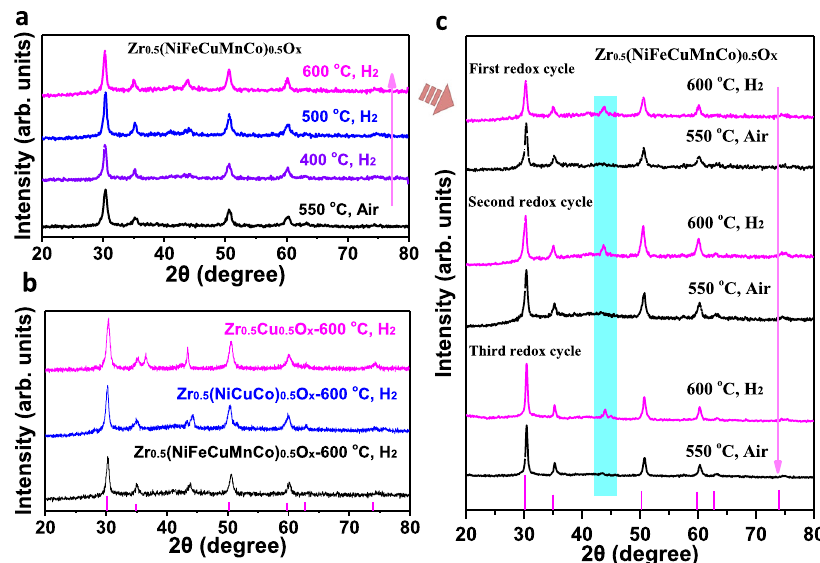
Fig. 5 The XRD patterns of doped ZrO x samples during redox processes. a The P-XRD patterns of Zr 0.5 (NiFeCuMnCo) 0.5 O x treated at 10% H 2 balance with N 2 at appoint temperature (400, 500, 600 °C) for 2 h. b The P-XRD patterns of Zr 0.5 Cu 0.5 O x , Zr 0.5 (CuCoNi) 0.5 O x , and Zr 0.5 (NiFeCuMnCo) 0.5 O x treated at 10% H 2 balance with N 2 at 600 °C for 2 h. c the P-XRD patterns of phase evolution in multi cycles between reductive and oxidative conditions. arb. units: arbitrary unit.